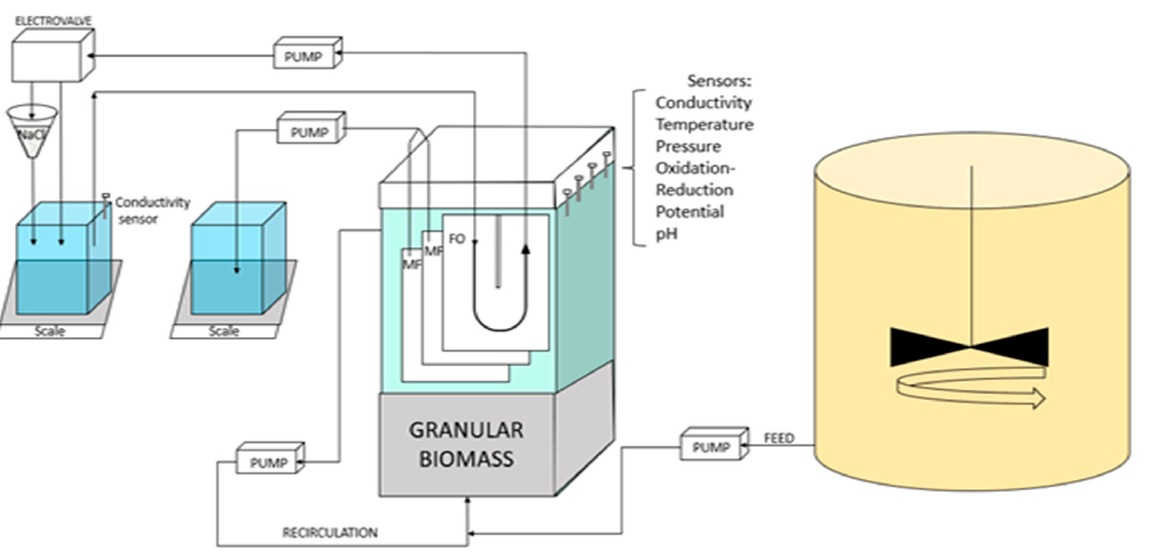
Figure 1. Experimental setup of the FO-G-AnMBR pilot.